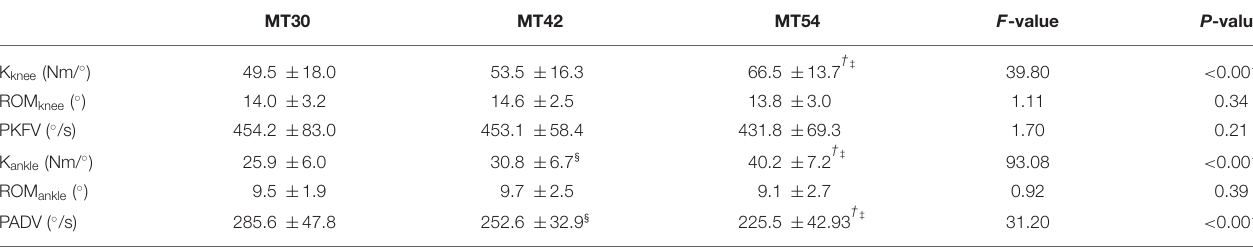
TABLE 1 | Mean ± SD of the joint stiffness, range of motion, and peak angular velocity of ankle and knee joint in the impact phase between shoe conditions.